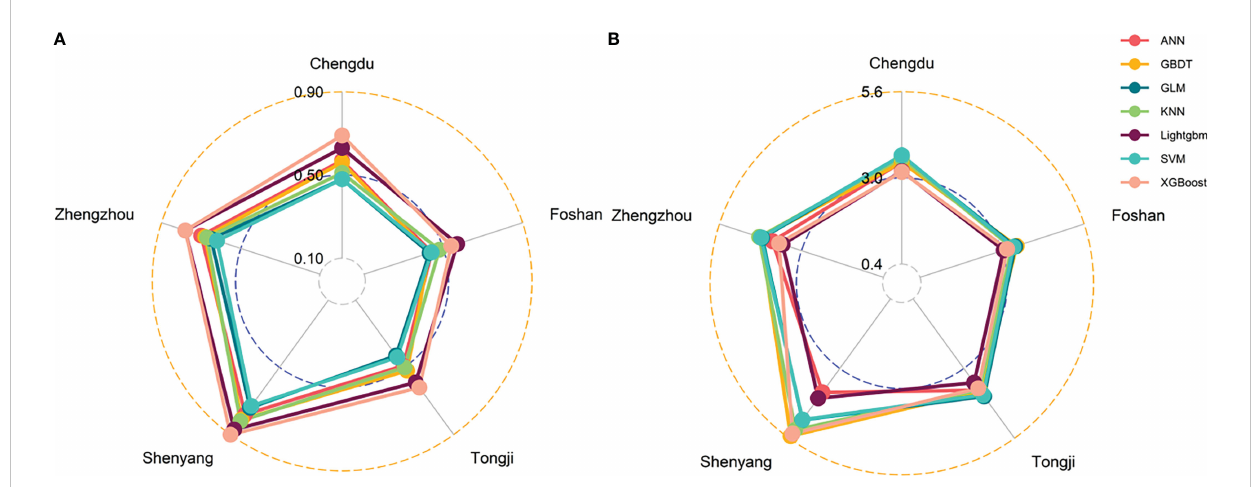
FIGURE 3 Radar plot showing correlation values (A) and mean absolute prediction errors (MAE) values (B) for the fi ve datasets using the seven different prediction